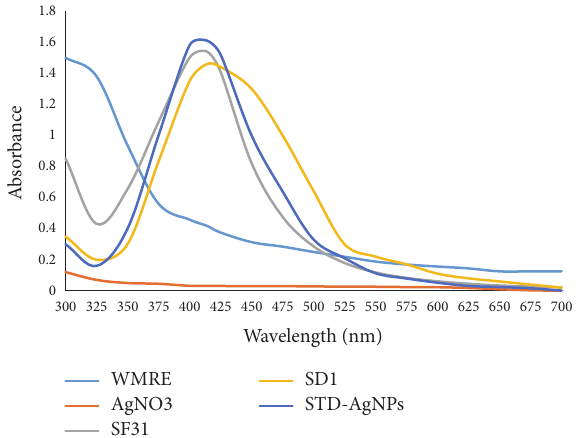
Figure 7: UV-Vis spectra of watermelon rind extract (WMRE), AgNO 3 (0.001 M) solution, sample SF 31 (WMRE-AgNPs), and sample SD 1